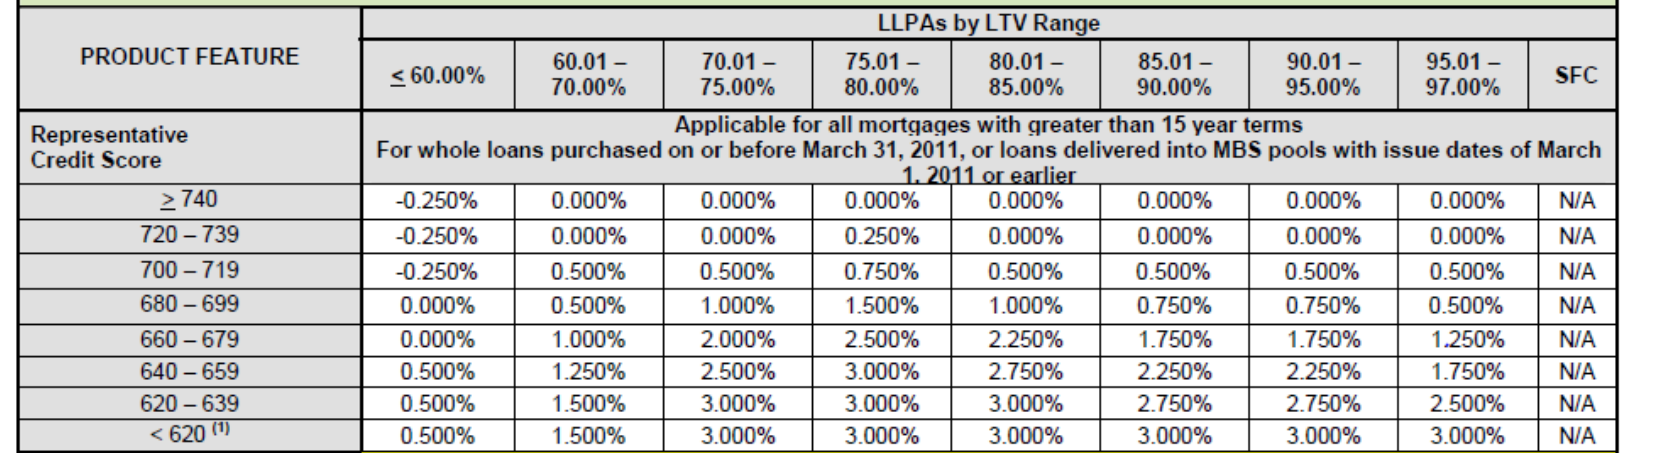
Figure 1: An Example of the GSE Grid Presented is the LLPA (Loan-Level Price Adjustment) Grid of Fannie Mae for 2011. The figure is from the Fannie Mae Selling Guide, dated 12/23/2010. (MCMs, now retired, refers to “My Community Mortgages”, a program of subsidized loans for low-income target areas.) The LLPA Grid has a parallel grid at Freddie Mac called the Credit Fees in Price chart. These grids provide the additional g-fee (guarantee fee) that lenders must pay the GSE for guaranteeing the mortgage, varying by LTV and credit score. In practice, these lump-sum fees are translated to flows concepts to be added to the interest rate passed on to borrowers to pay for credit